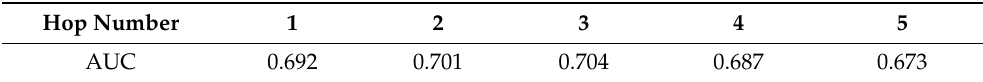
Table 3. The results of AUC w.r.t. different hop numbers.